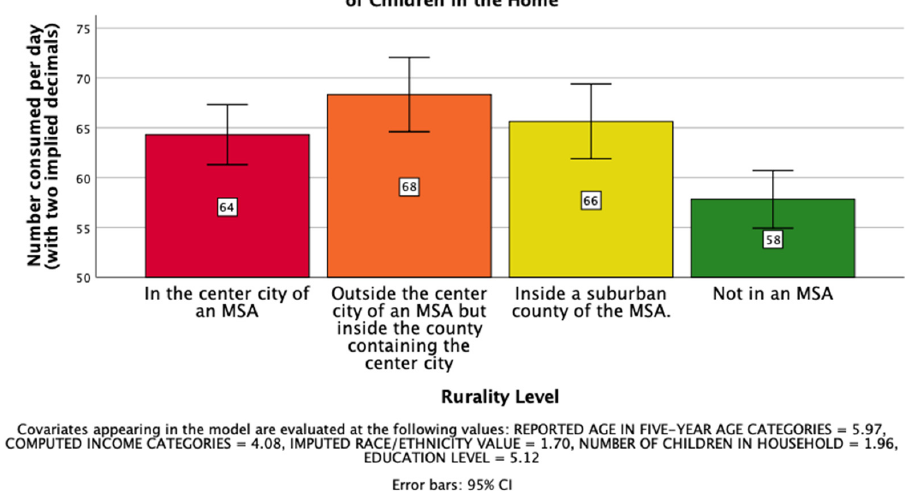
Figure 2. National Mean Daily Dark Green Vegetable Intake.